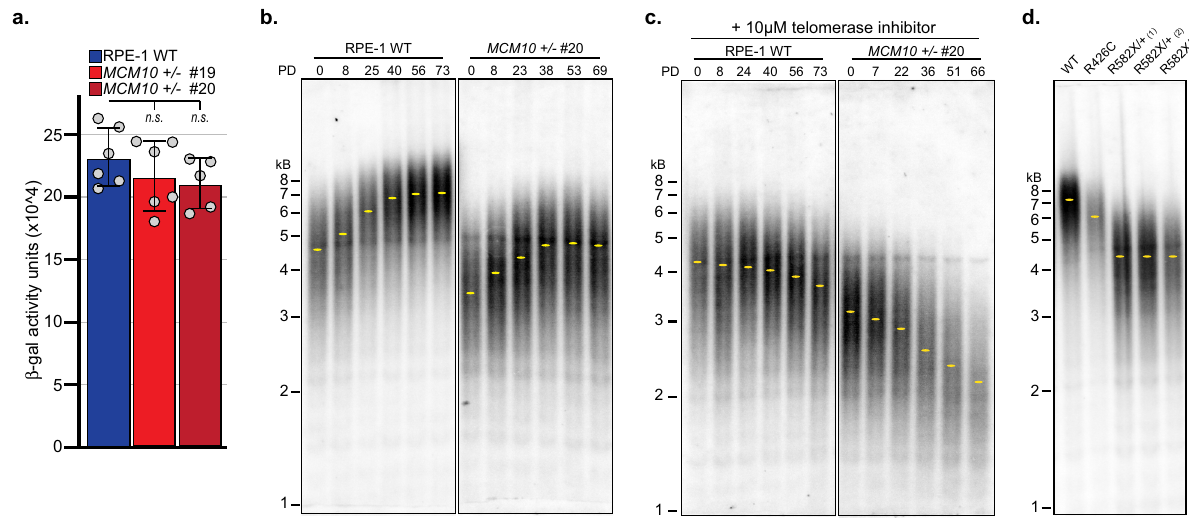
Fig. 5 MCM10 heterozygous RPE-1 cell lines have telomere maintenance defects. a Average β -gal activity in wild type (blue) and clonal MCM10 + /- cell lines (red). For each cell line n = 6 replicates. Individual data points are indicated (gray circles). Error bars indicate SD and signi fi cance was calculated using an unpaired, two-tailed student ’ s t-test with *<0.05; **<0.01, ***<0.001. b TRF analysis in wild type and MCM10 + /- clone #20 cell lines. PDs and location of peak intensity (yellow dots) are indicated. c TRF analysis in wild type and MCM10 + /- clone #20 cell lines in the presence of telomerase inhibitor. PDs and location of peak intensity (yellow dots) are indicated. d TRF analysis in wild type and MCM10 mutant cell lines carrying NK-associated patient variants. Yellow dots indicate the location of peak intensity. Source data for panels a – d , including relevant exact p-values, are provided in the Source Data fi